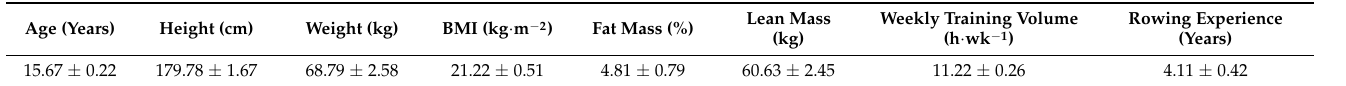
Table 1. The characteristics of the rowers at the baseline. Data are the mean ± SE. BMI, body mass